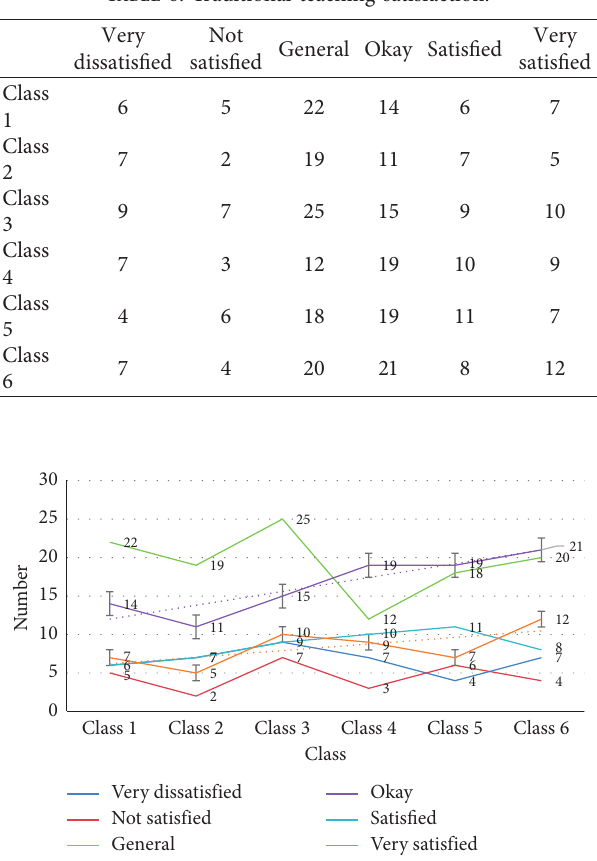
Figure 8: Traditional teaching satisfaction